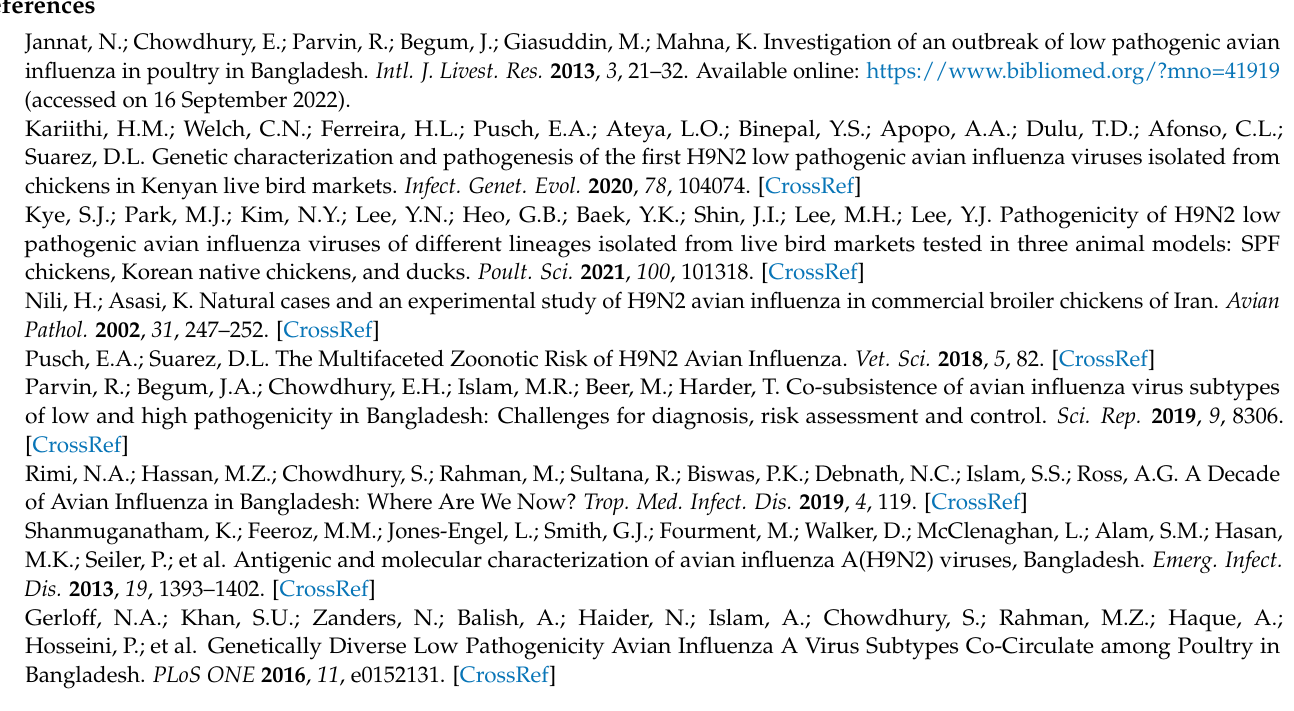
tine started appear normal. Figure S3: Seroconversion of infected Sonali and broiler after getting 106 EID 50 / mL of each virus. Level of significance are calculated through One-way ANOVA with Tukey’s multiple comparison test and shown as asterisk mark. Table S1. Summary information of AIV H9 isolates from chickens characterized in this study. Table S2. GISAID accession numbers